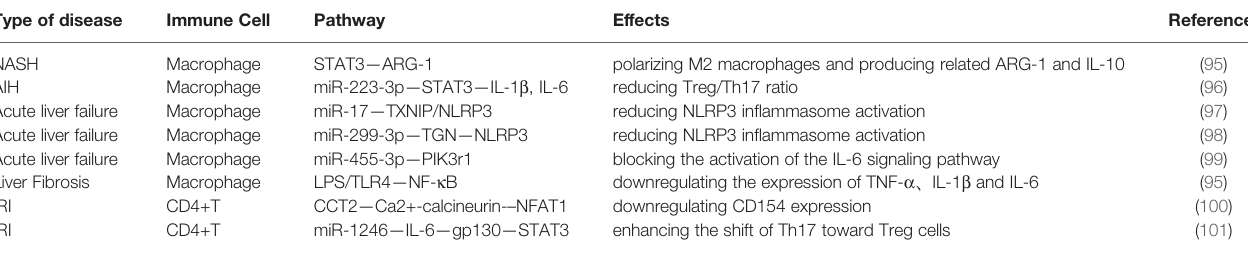
TABLE 1 | The role of MSC-EVs in the modulation of liver immunity in various liver